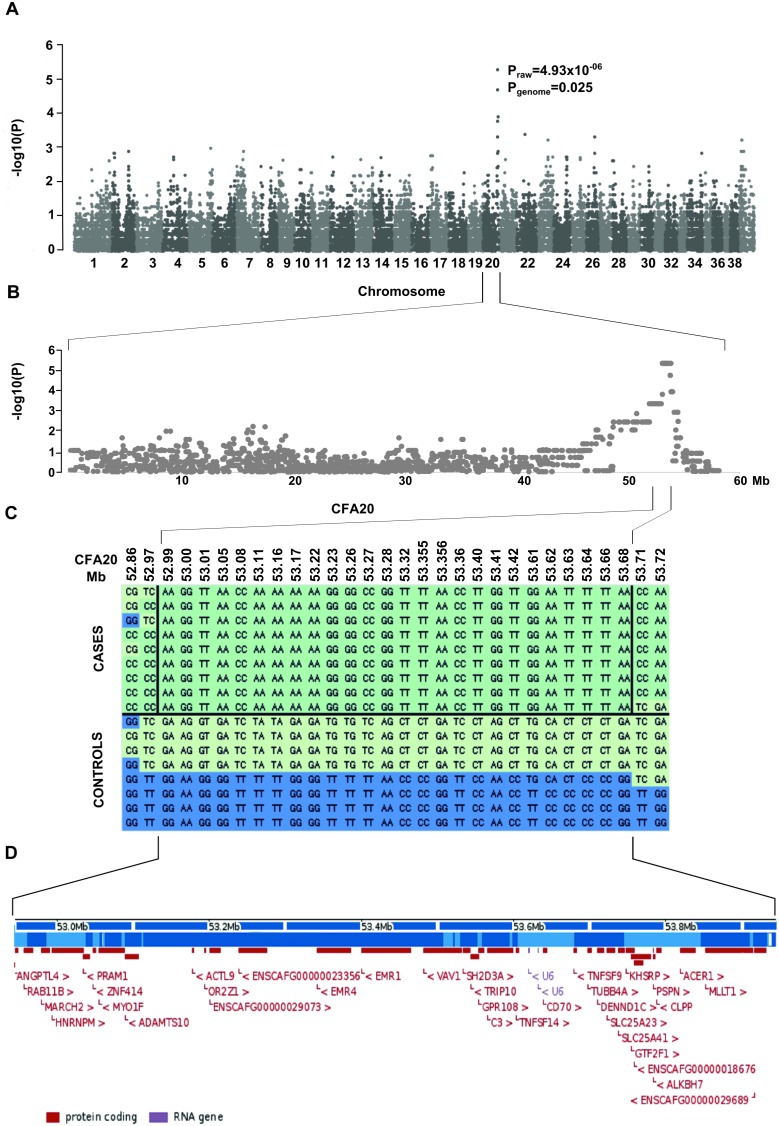
Genome wide association study.
A) A Manhattan plot of genome-wide case-control association analysis with 8 cases and 9 controls indicate the most highly associated region in CFA20. B) The glaucoma associated region on chromosome 20 spans from 53.1 Mb to 53.8 Mb. C) Genotypes at the associated region on CFA20. All cases share a 750 kb homozygous block. D) The associated region harbors 35 genes of which only ADAMTS10 has been associated with POAG.